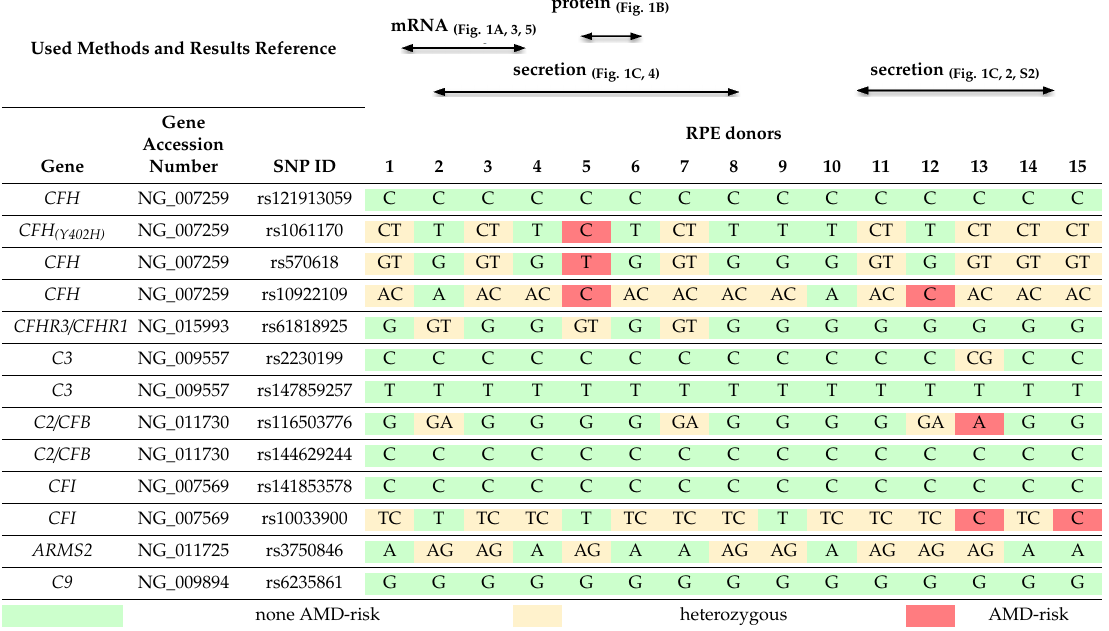
Table 1. Human primary retinal pigment epithelium (hpRPE) cell genotyping and experimental assignment in this study. Used Methods and Results Reference